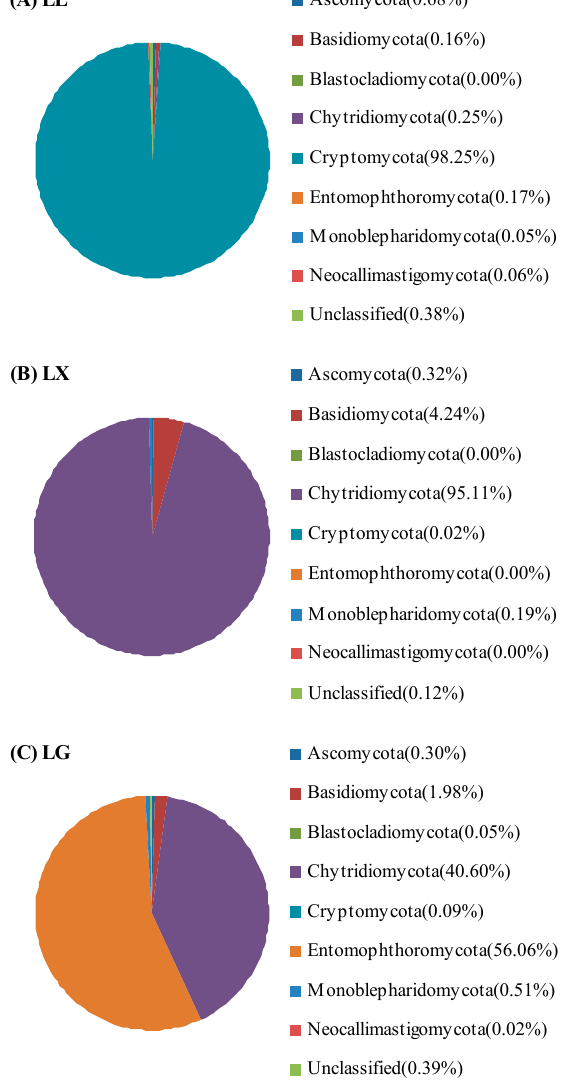
Figure 4. Taxonomic classification of water fungal community reads of Illumina Miseq data of ( A ) Lianhu lake (LL), ( B ) Xingqing lake (LX), and ( C ) Geming lake (LG) into phylum levels using the UNITE (http://unite.ut.ee) classifier